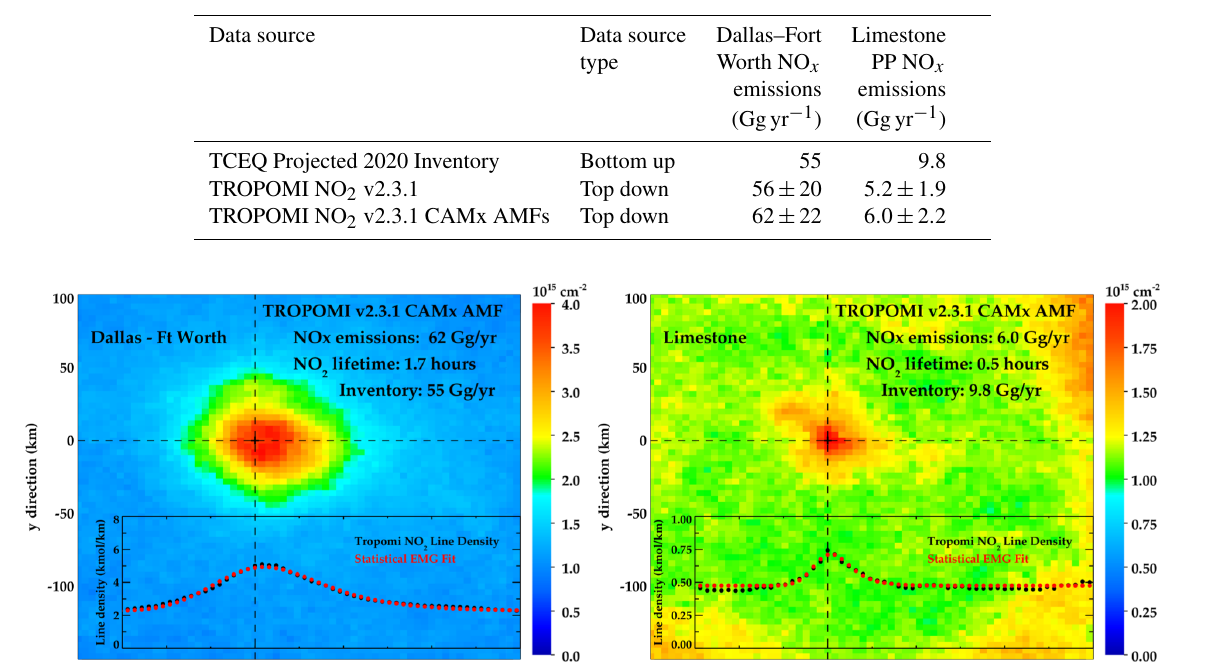
Table 2. NO x emission rates for Dallas–Fort Worth and the Limestone power plant from the TCEQ Emissions Inventory and various iterations of the TROPOMI NO 2 algorithm.